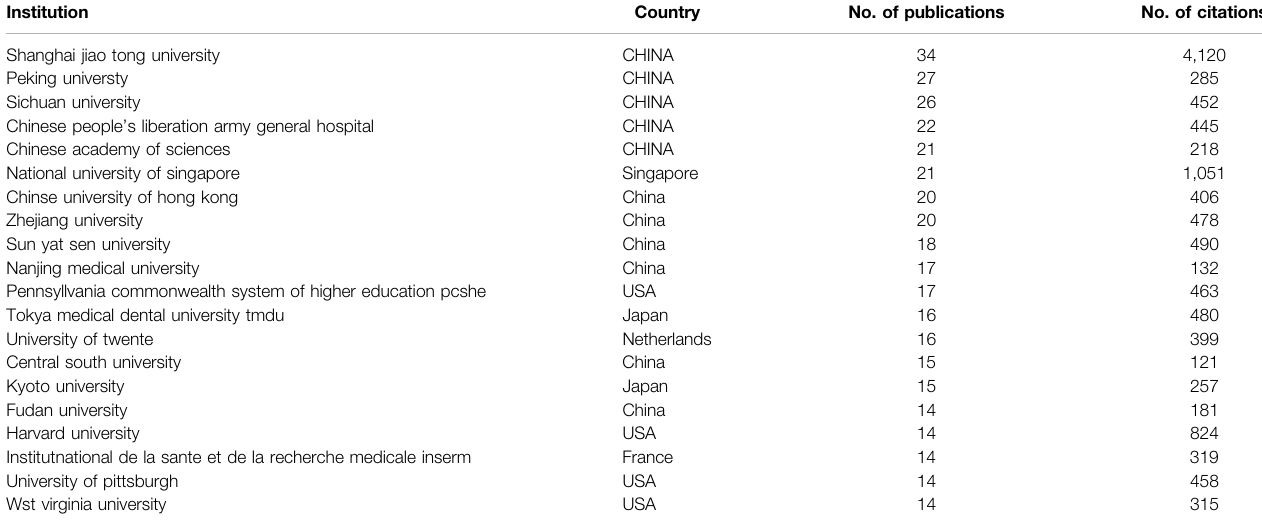
TABLE 2 | Top 20 institutions with the most publications in the fi eld of stem cells for cartilage regeneration. Institution